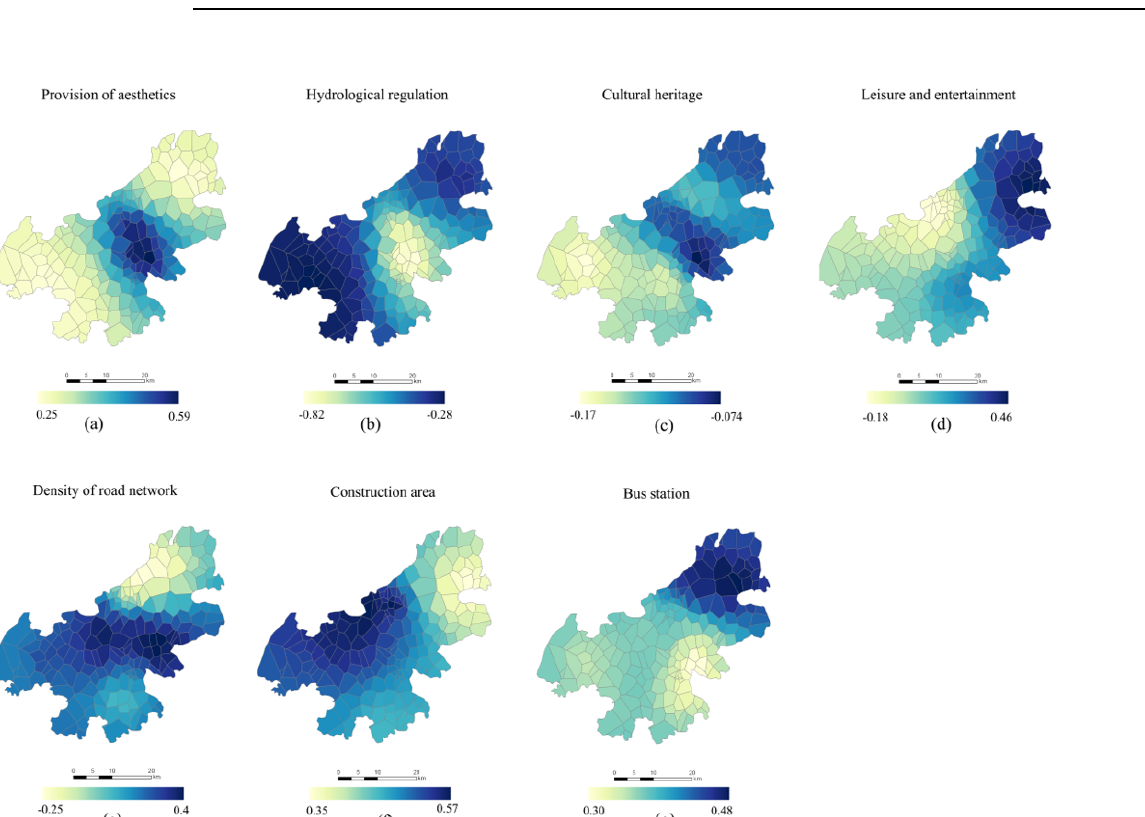
Table 4. Calculation results of geographical weighted regression (GWR) model.